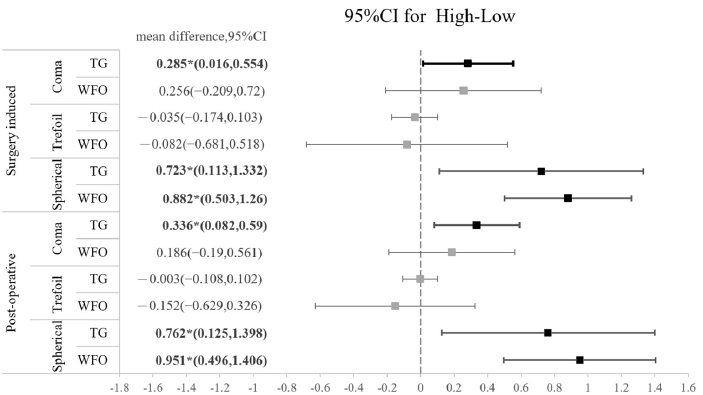
Figure 2. Forest plot of the standardized mean difference of surgically induced HOA or postoperative HOA between high myopia and low myopia on coma, trefoil, and spherical aberration with 95% confidence intervals stratified by TG vs. WFO.